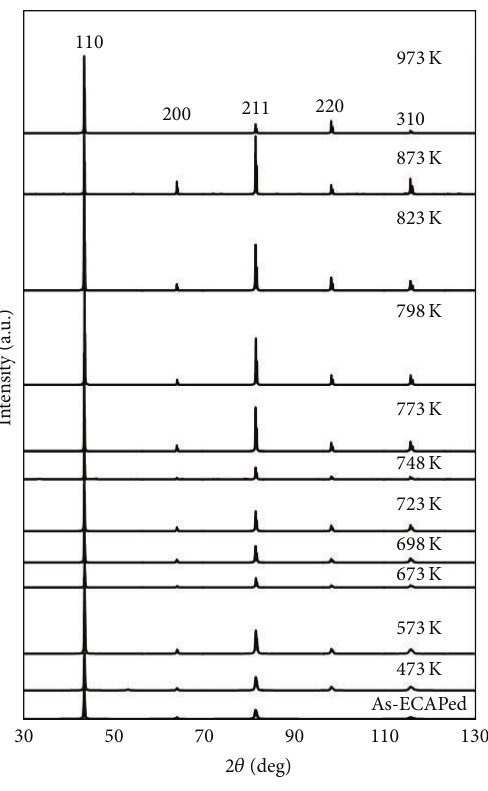
Figure 8: X-ray {110} diffractions after ECAP and